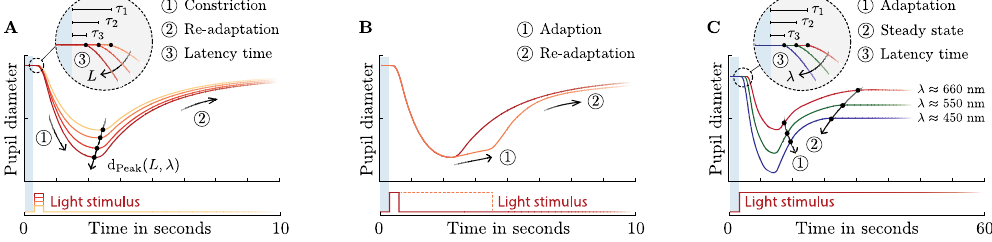
Figure 1. Idealized representation of the pupillary light response caused by different types of stimuli. ( A ) Phasic pupil response at one short light pulse. As the luminance intensity increases, the constriction velocity and the peak pupil constriction increases. At the same time, the latency of the pupil decreases with increasing luminance intensity. After peak constriction, the pupil undergoes re-adaptation. ( B ) During longer exposure times, the pupil adapts to the light stimulus itself, resulting in an increasing dilatation up to the equilibrium state. ( C ) The latency time, constriction velocity and peak constriction depend on the used light wavelength. Short wavelength stimuli cause a lower latency and a greater pupil constriction. The equilibrium time is reached faster with short